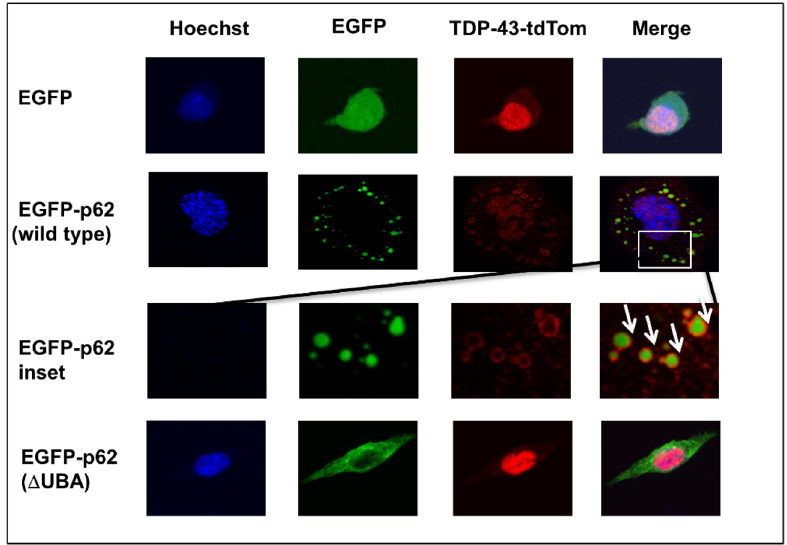
Figure 1. Expression of EGFP-p62 causes TDP-43 WT cytoplasmic mislocalisation in a UBA domain dependent manner. Cells co-expressing TDP-43 WT and either EGFP or EGFP-p62 (WT or ΔUBA) were fixed and stained with Hoechst then visualized by confocal microscopy. Arrows show TDP-43 forming a shell around wild type p62 (inset). Three independent experiments were performed. Cells expressing both TDP-43-tdTomato and EGFP construct were imaged from random fields of view with a minimum of 10 cells imaged per experiment. TDP-43-tdTomato co-localisation with the nucleus was determined by calculating the Pearson’s co-efficient with ImageJ. Post-hoc ANOVA Bonferroni test was performed in SPSS.